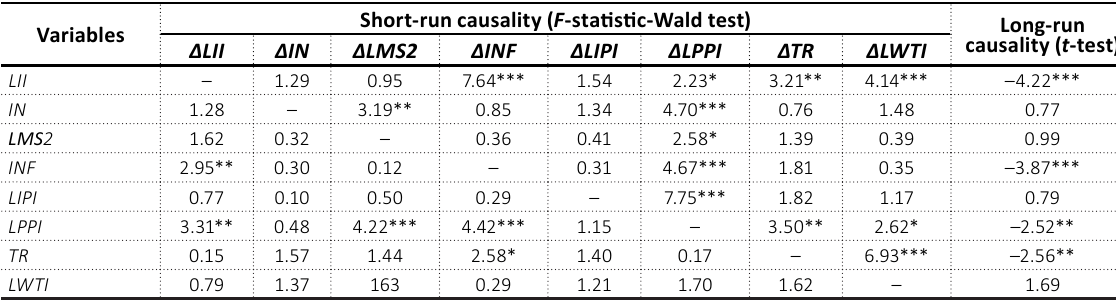
Table 7. VECM Granger causality